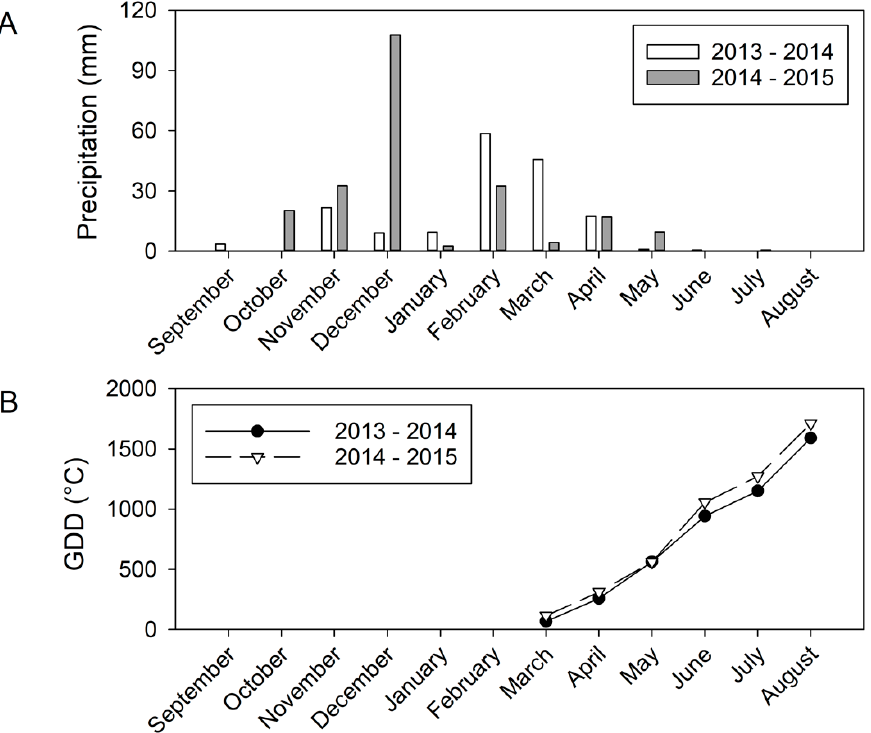
Figure 1. Weather at the experiment site in 2014 and 2015, acquired from California Irrigation Management Information System (CIMIS) station (#206, Denair, CA). ( A ) Monthly precipitation. Note: GDDs were calculated until August, when the harvests in both years occurred. ( B ) Growing degree day accumulation starting in March of each year